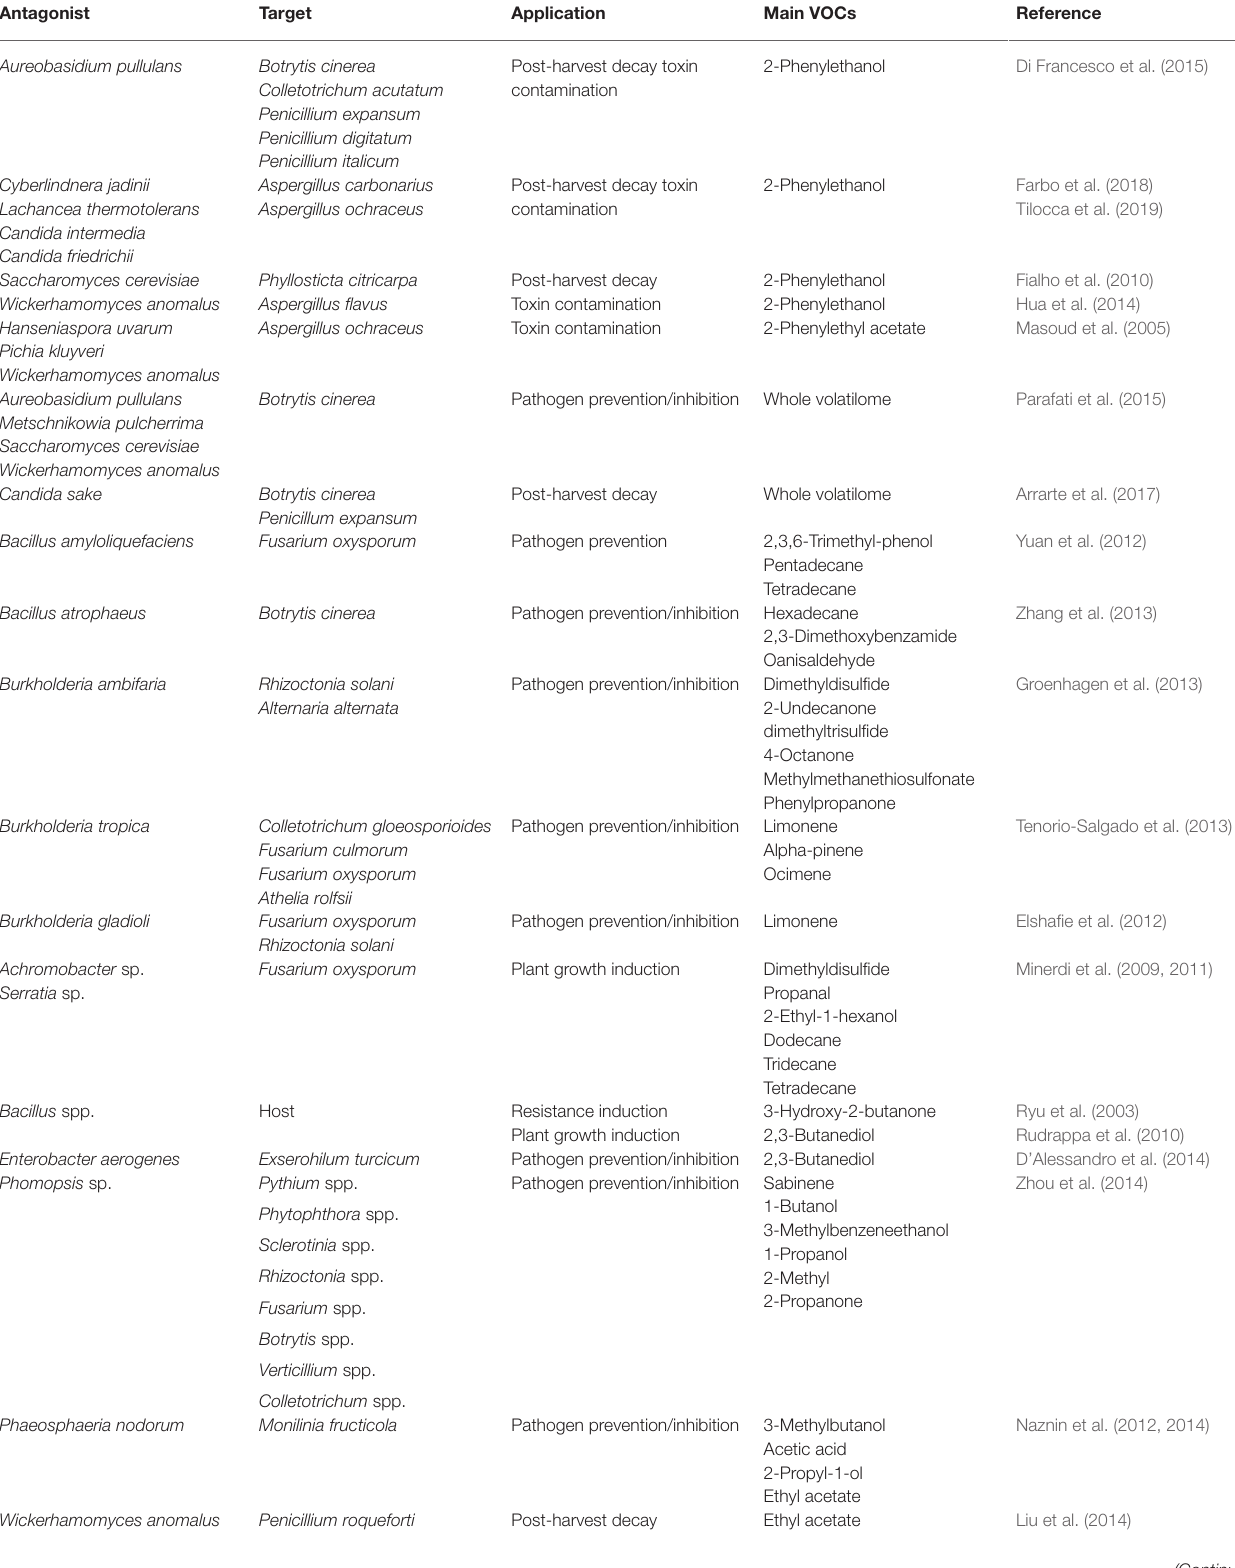
TABLE 1 | Main biological control agents emitting volatile organic compounds, their target pathogen, framework application, and primary volatilome